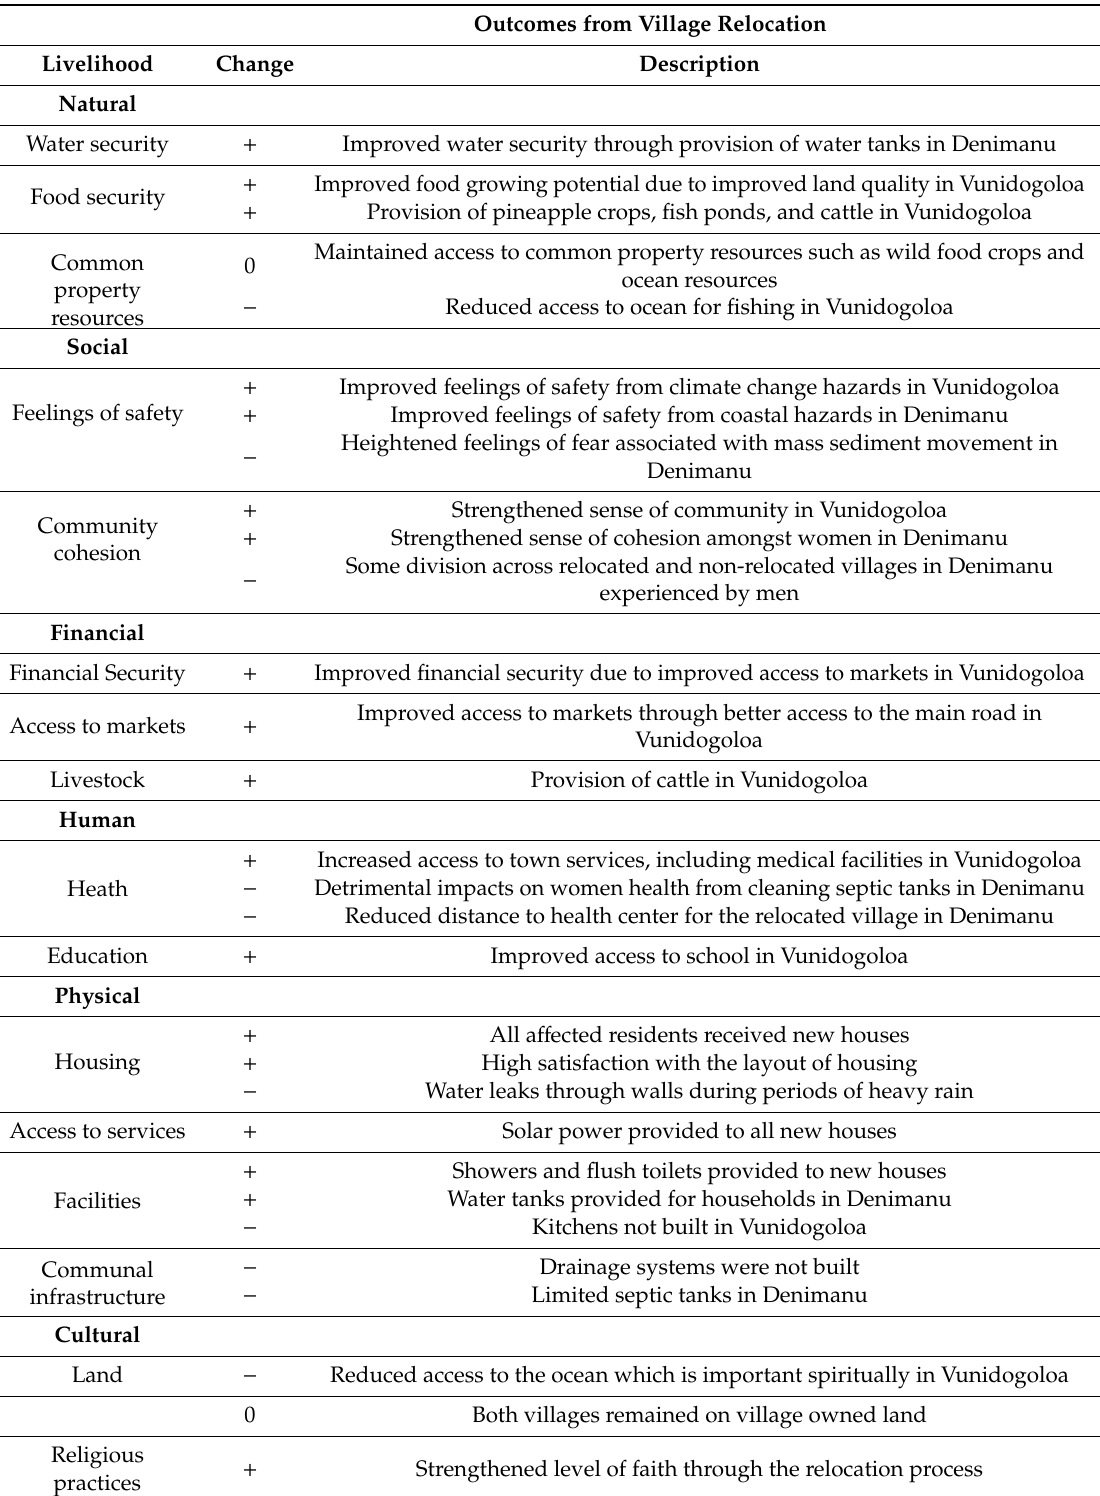
Table 1. Outcomes on community livelihoods from the village relocations in two communities, denoted as: Positive change ( + ), no change (0), negative change ( −